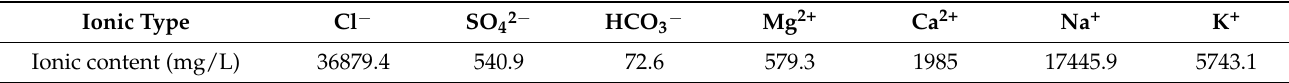
Table 2. Ionic composition of simulated formation